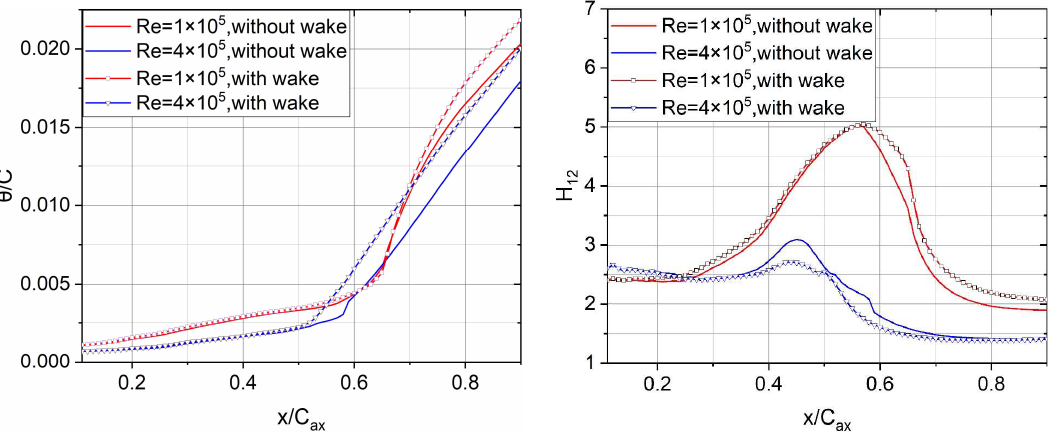
Figure 13. Comparison of boundary layer momentum thickness and shape factor on suction surface boundary layer at 50% span.